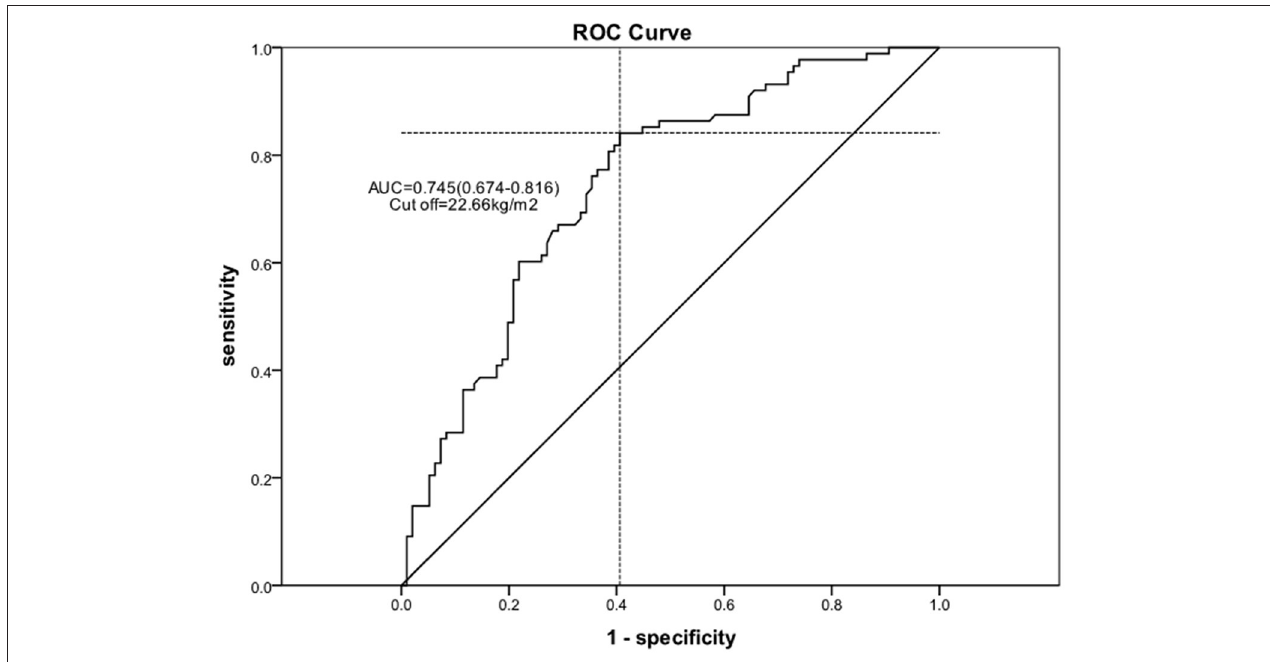
FIGURE 3 | ROC curve for the cutoff value of the BMI.